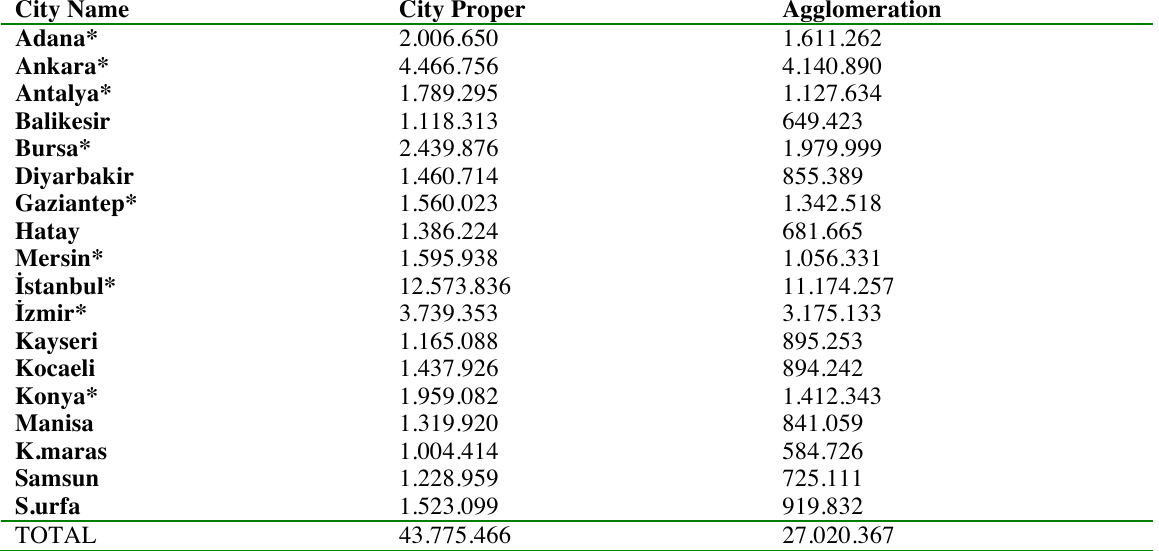
Table 2 : City size according to city proper and agglomeration definitions City